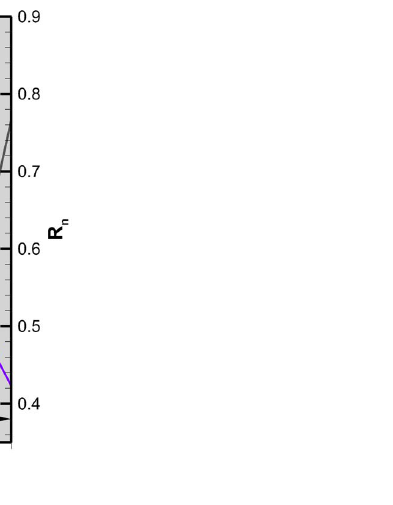
Fig. 13. Subumbrella volume. Subumbrella volume and bell radius as a function of time for one full swimming cycle. The diameter is taken as the x-position of the bell margin.